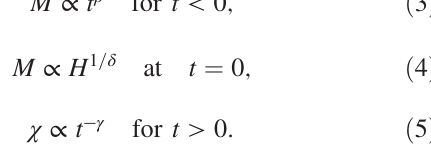
¼ 0 . 005 , (b) x ¼ 0 . 008 , and (c) x ¼ 0 . 01 with linear fits (solid lines) at the